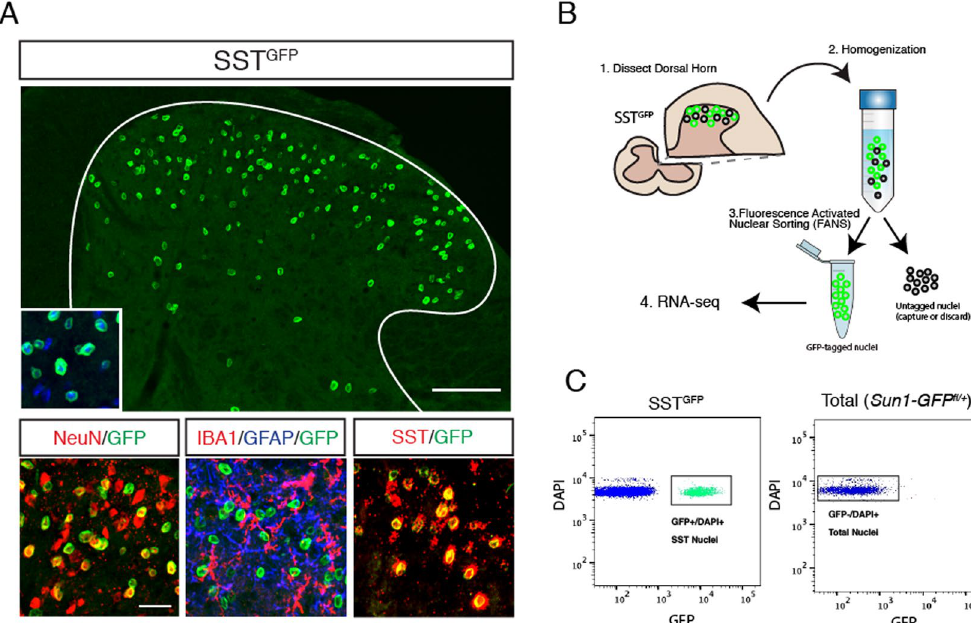
Figure 1. Cell type-specific nuclear tagging and capture of SST neurons in the spinal dorsal horn. ( A ) SST GFP mice express the Sun1-GFP nuclear tag in SST neurons in the lumbar dorsal horn (a). The GFP-tagged SST neurons co-localize with the neuronal marker NeuN (red, b), but not with the microglial marker IBA1 (red) or the astrocyte marker GFAP (blue) (c). (d) GFP + (green) nuclei overlap extensively with native Sst mRNA (red). ( B ) Schematic of overall experimental workflow. (1) The dorsal segment from one side of the lumbar spinal cord is dissected. (2) Nuclei are liberated by Dounce homogenization in nuclear lysis buffer. (3) Nuclei are then captured using Fluorescence Assisted Nuclear Sorting. (4) The isolated RNA is processed for RNA-seq. ( C ) GFP + /DAPI + nuclear were captured from SST GFP (left). No GFP + nuclei were present in Sun1-GFP (fl / + ) control animals; all DAPI + nuclei were